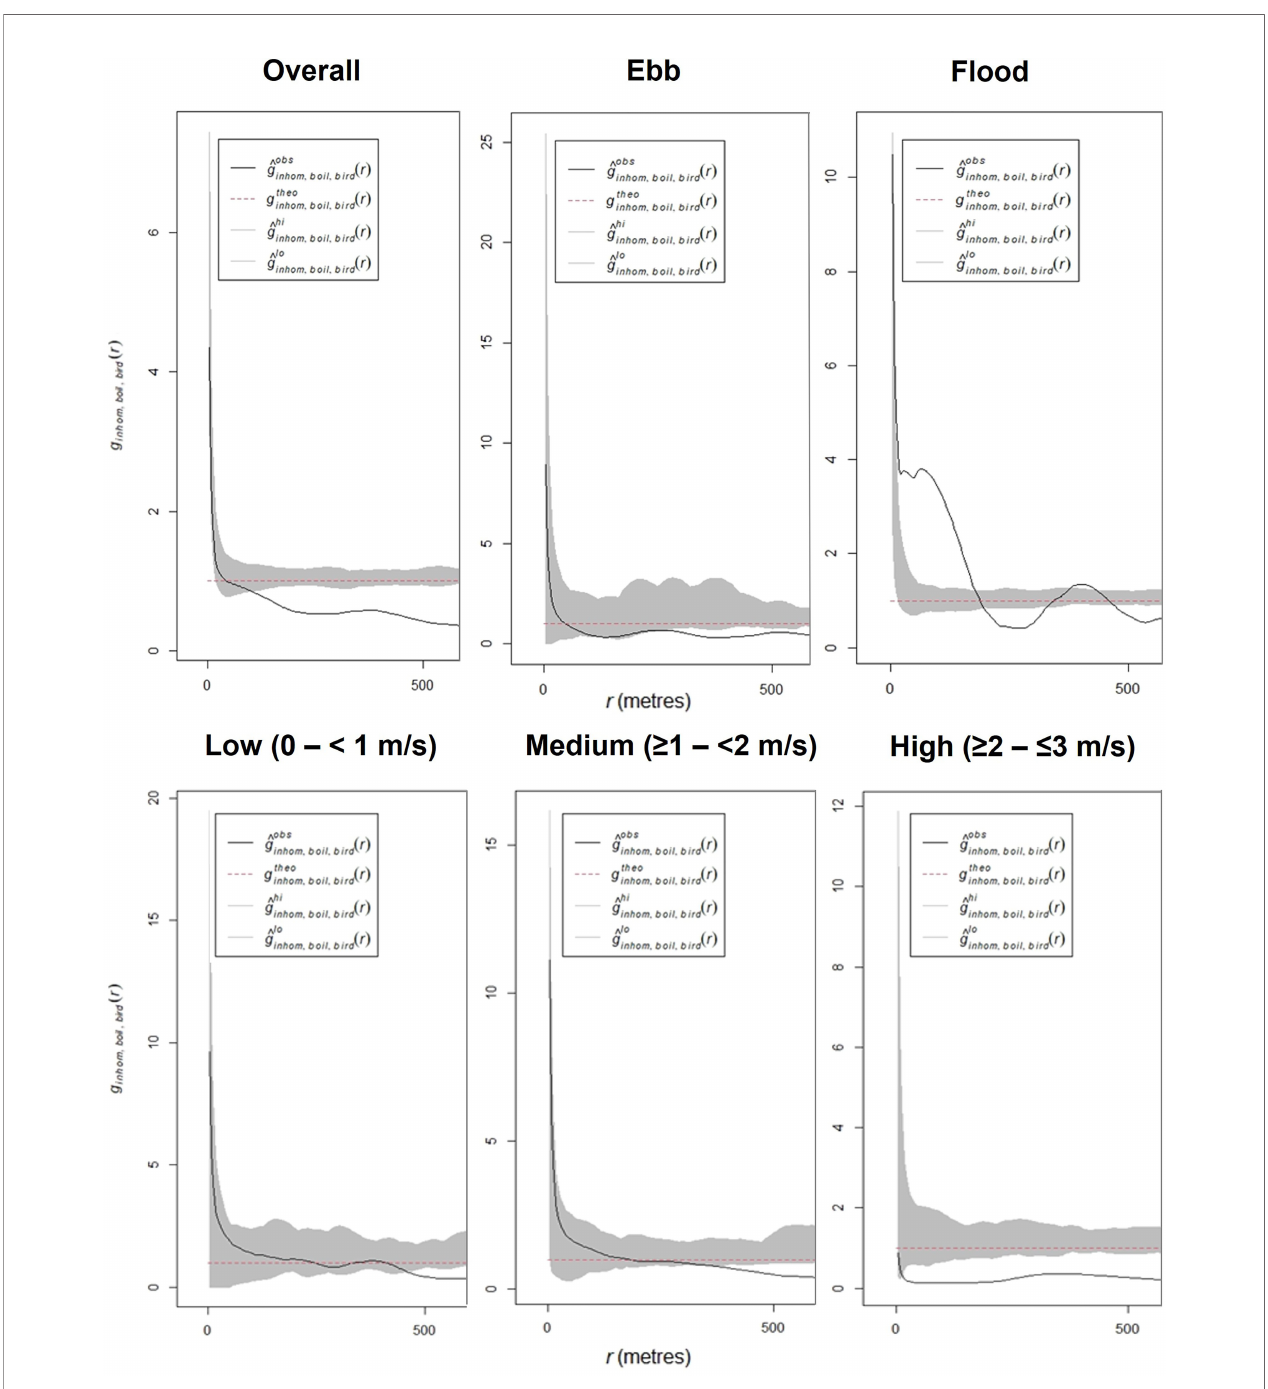
FIGURE 5 | Multitype pairwise correlation function plot of kolk-boil and auk point associations overall, across ebb and fl ood tidal phases and at differing current velocity ranges (at 40 m bandwidth), across the Inner Sound and island of Stroma areas of the Pentland Firth. Grey shaded area (hi, lo) represents 95 % con fi dence intervals, black line (obs) the observed values and red dashed line (theo) indicates the theoretical